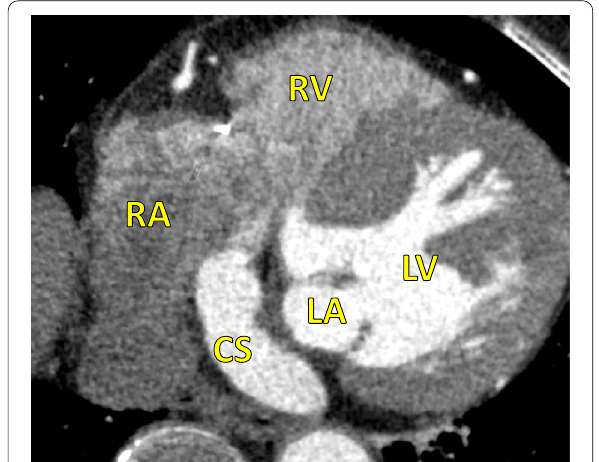
Fig. 5 Postoperative cardiac computed tomography. Postoperative cardiac computed tomography image showing successful repair of the unroofed coronary sinus without any residual shunt. LA left atrium, LV left ventricle, RA right atrium, RV right ventricle, CS coronary